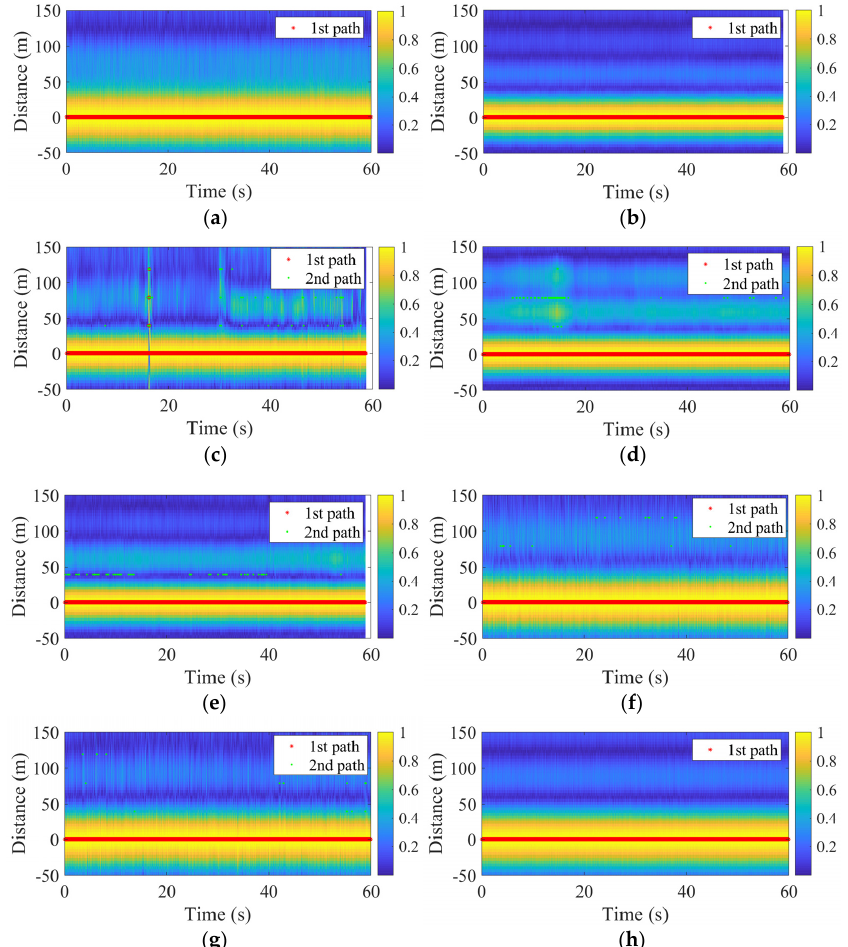
Figure 7. Multipath acquisition results in static tests. ( a ) channel 17, ( b ) channel 21, ( c ) channel 24+2, ( d ) channel 26, ( e ) channel 31, ( f ) channel 33, ( g ) channel 47, ( h ) channel 48.